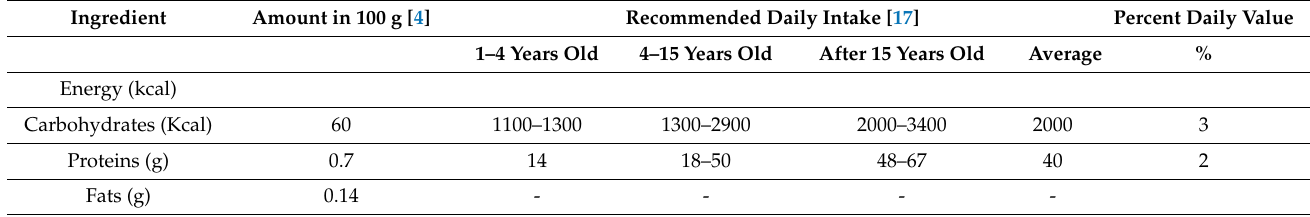
Table 2. Chokeberry Nutrients and Recommended Daily